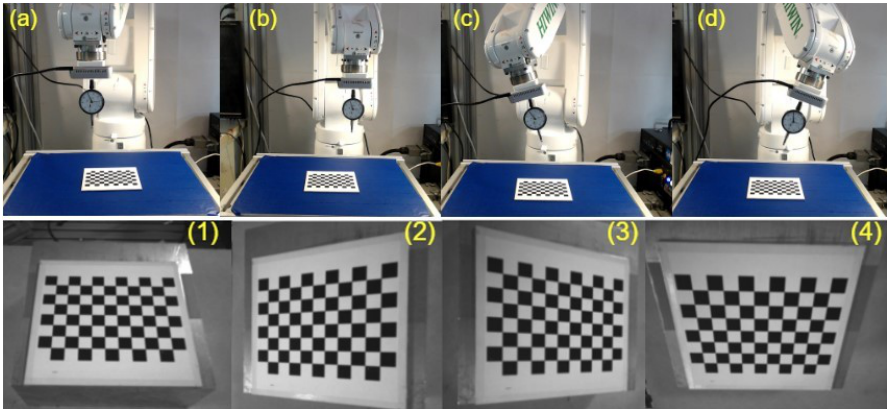
Figure 5. Hand-eye calibration process utilized. ( a – d ) Shows robot different poses, ( 1 – 4 ) Showcases the corresponding images captured during the robot’s execution of poses ( a – d